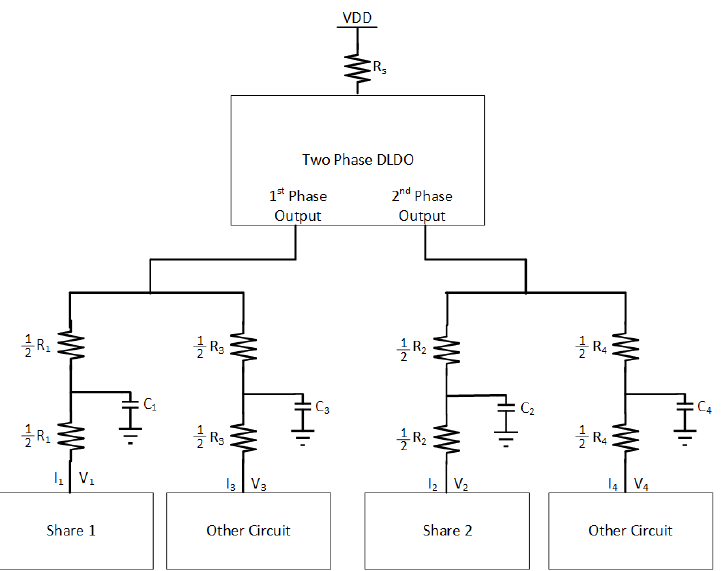
Figure 20. PDN for masking shares and other circuits when each masking share is connected to one of the phases of a two-phase DLDO voltage